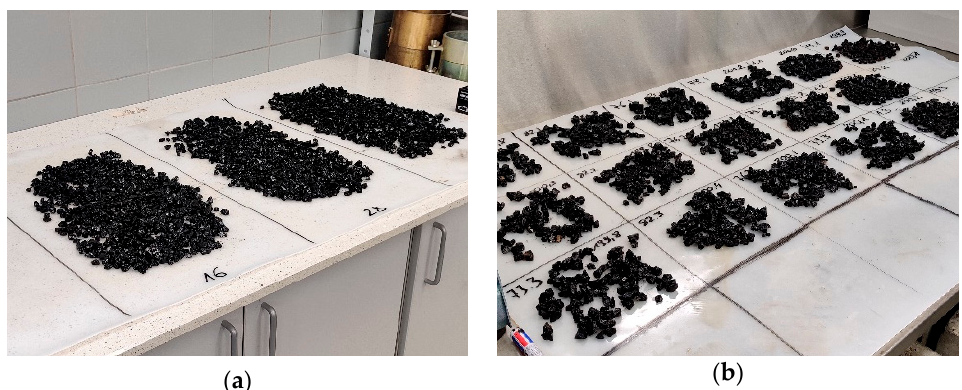
Figure 1. Sample preparation process: ( a ) coated aggregates left for cooling; ( b ) samples after the boiling water stripping test.